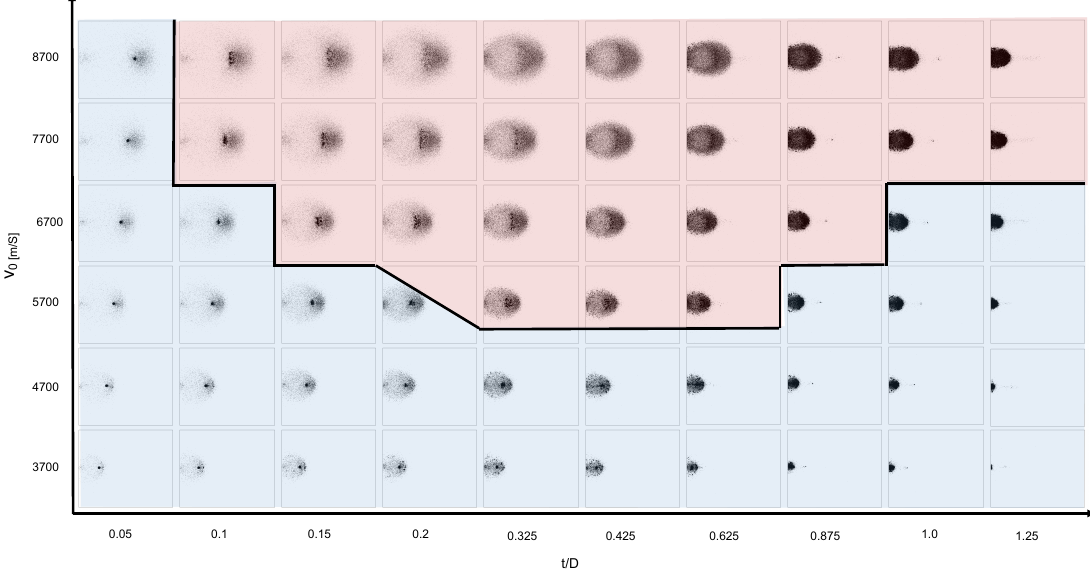
Figure 17. Snapshots of the debris clouds produced under different impact conditions. The impact conditions leading to a valid model is shown in red; invalid regions are shown in